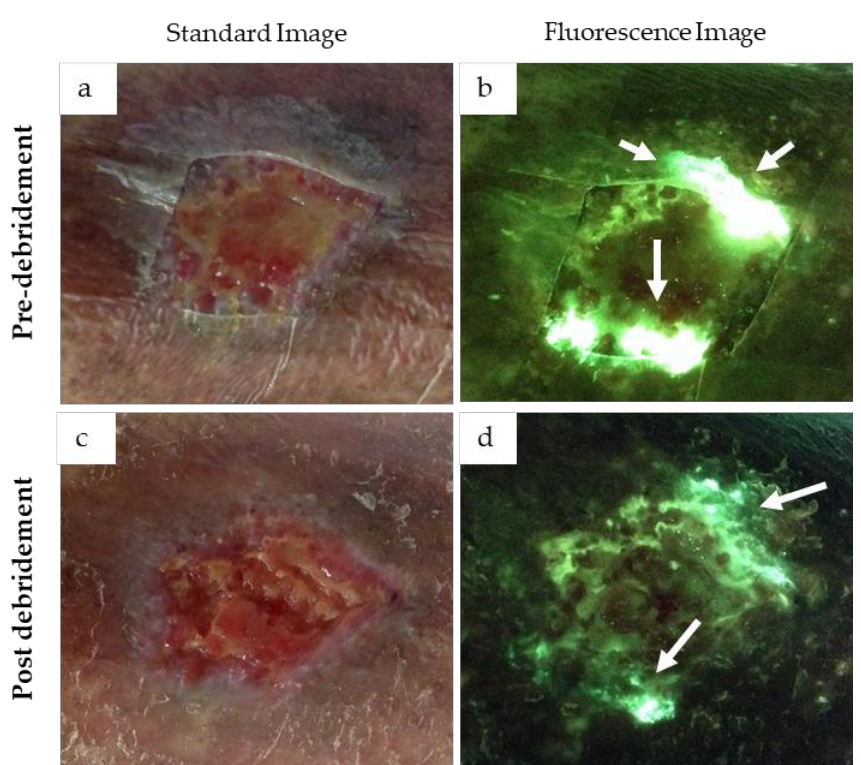
Figure 4. Presence of cyan fluorescence in a 78-year-old female patient with a venous leg ulcer. Standard images ( a , c ) and fluorescence images ( b , d ) were captured at the point-of-care before and after debridement. Bright white/cyan fluorescence signal was observed before debridement ( b ). Cyan fluorescence signal intensity was significantly reduced after debridement ( d ) but was still clearly present (white arrows).